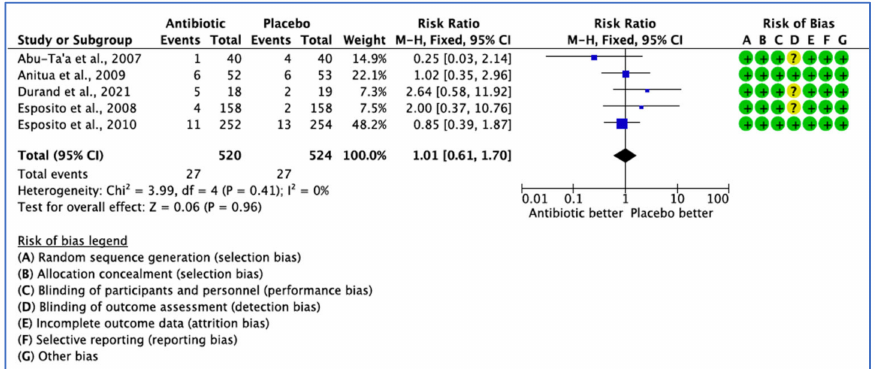
Figure 5. Forest plot of comparison between AB and placebo, which gives the summary estimate (centre of diamond) and its 95% confidence interval CI (width of diamond) based on postoperative complications. Statistical method: Mantel-Haenszel with fixed-effect model [26,29,31,32,36].